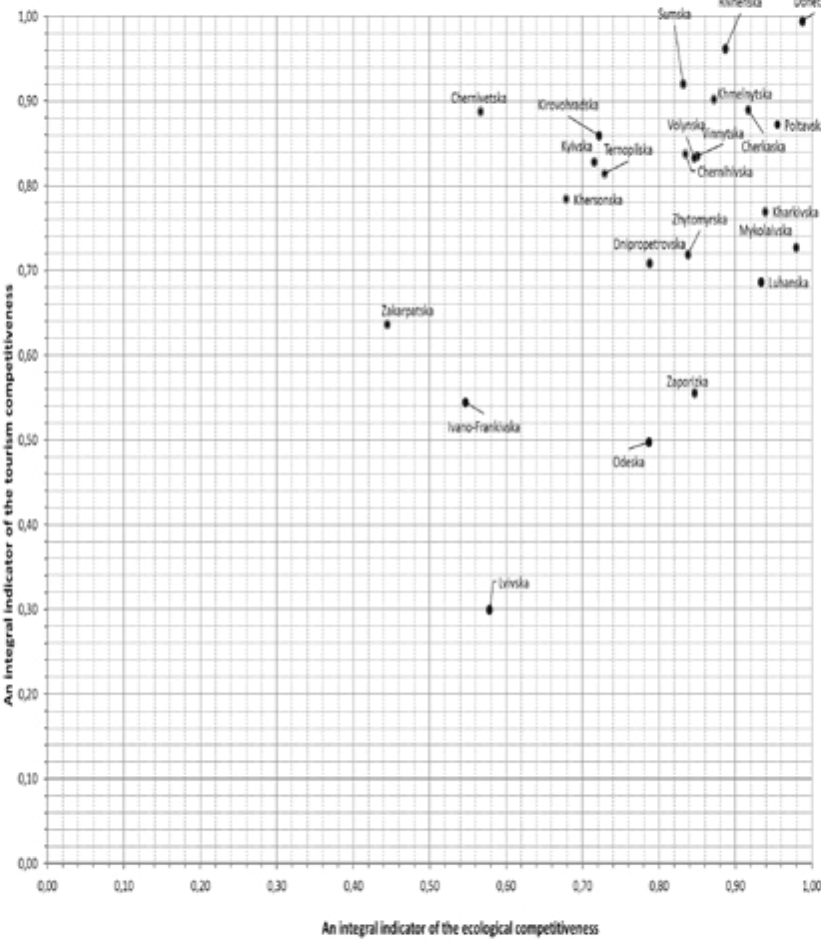
Fig. 2: The matrix of green tourism potential in 2019 (Ukraine’s regions)